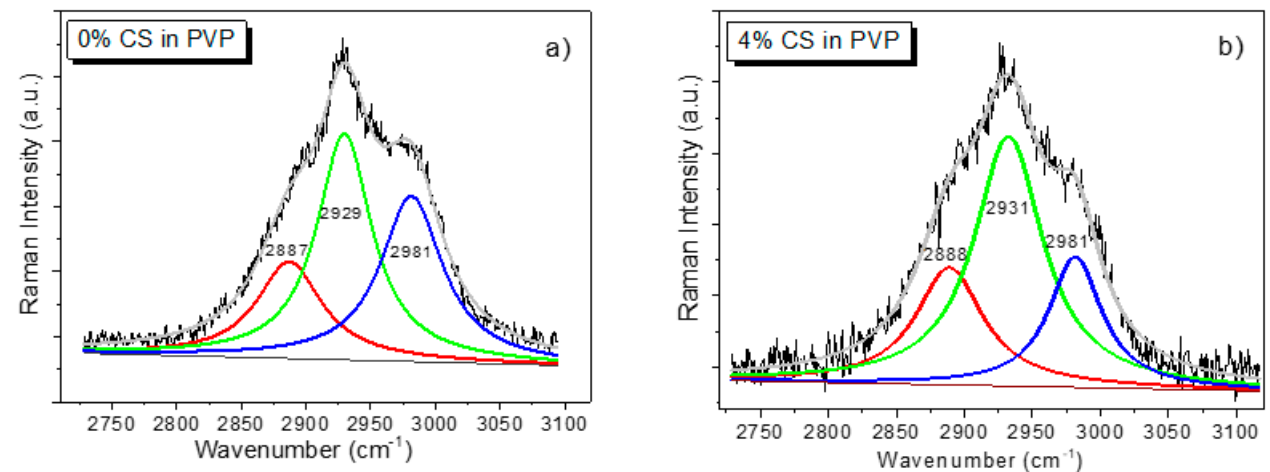
Figure 4. Raman spectra and their fitting in the region of 2720–3130 cm − 1 for fibre composites with ( a ) 0% CS and ( b ) 4% CS.